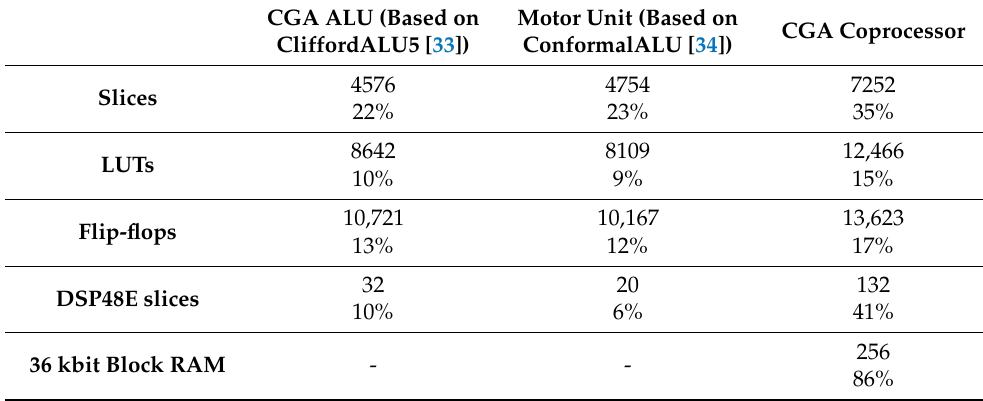
Table 5. Resource utilization on the Xilinx Virtex-5 XC5VFX130T FPGA device. CGA ALU (Based on Motor Unit (Based on CGA Coprocessor CliffordALU5 [33]) ConformalALU [34]) Slices